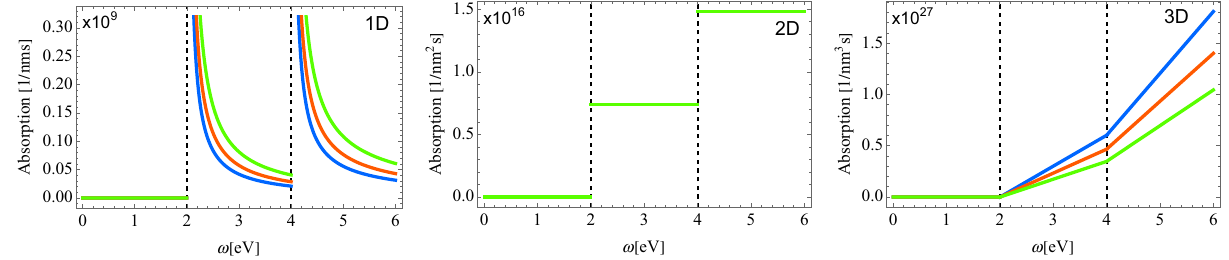
Figure 1. Spectrum of the absorption probability in each dimensionality for 1b processes. The parameters 25 1.443 10 2 eV is the energy spectrum of the internal η used are: m kg is the mass of atom. � η − = × = · 3 29 C d E 0 2 10 3.584 10 m the transition motion, eV is the transition matrix element with d η 0 η 0 · ˆ − − | | = × = × · 100 KV/cm is electric field intensity. k ω/ c is the wavevector of light. For dipole matrix element; ˆ E 0 = = 1 1 1 80 µ m 150 µ m 300 µ m 1D, the condensate densities are n 1 d (blue), n 1 d (red), n 1 d (green). For − − − = = = 3 3 2 100 µ m 250 µ m 320 µ m 2D, n 2 d . For 3D, the condensate densities are n 3 d (blue), n 3 d (red), − − − = = = 3 n 3 d 400 µ m − =